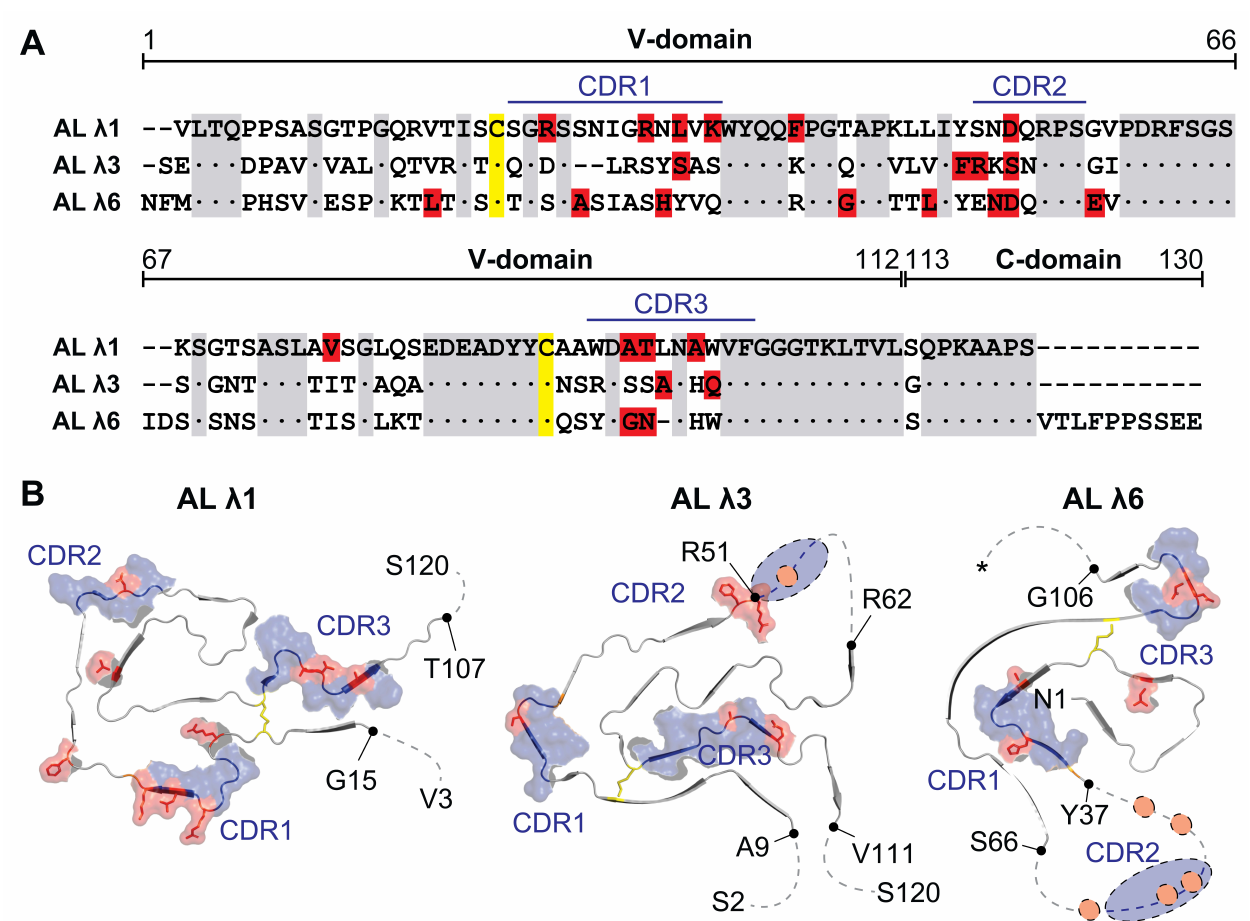
Figure 3. Sequence alignment and location of the mutational positions in the fibril structure. ( A ) Sequence alignment of the AL proteins. Conserved residues (grey), disulfide bridge (yellow) and mutated residues in respect to the germline (red) are highlighted. Dot indicates identical residue. Dash indicates absence of a residue. ( B ) Cross-sectional view of the AL protein fold. The first and the last residue of the ordered segments, as well as the first and the last residue of the fibril protein are indicated. Asterisk: variable C terminal end reported (position 130, 135, 151). The numbering of the amino acids refers to the alignment of the 3 AL proteins. Red: mutated position. Blue: CDRs. Yellow: disulfide bridge. Dotted line: disordered segment. PDB entries: AL λ 1 (6IC3), AL λ 3 (6Z1O), AL λ 6